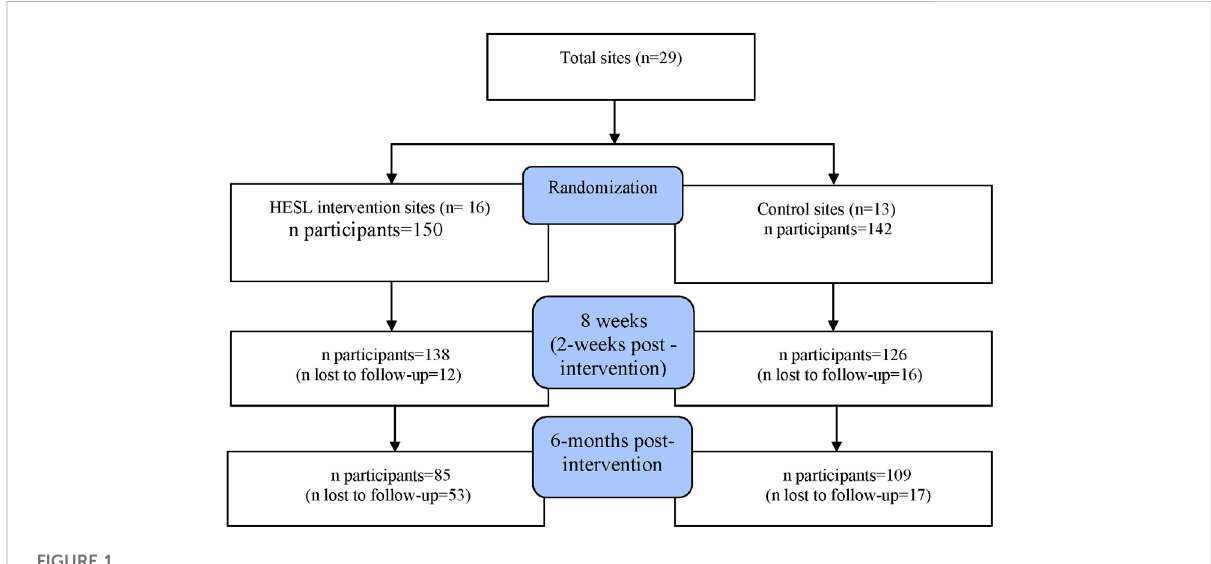
FIGURE 1 Study Consort